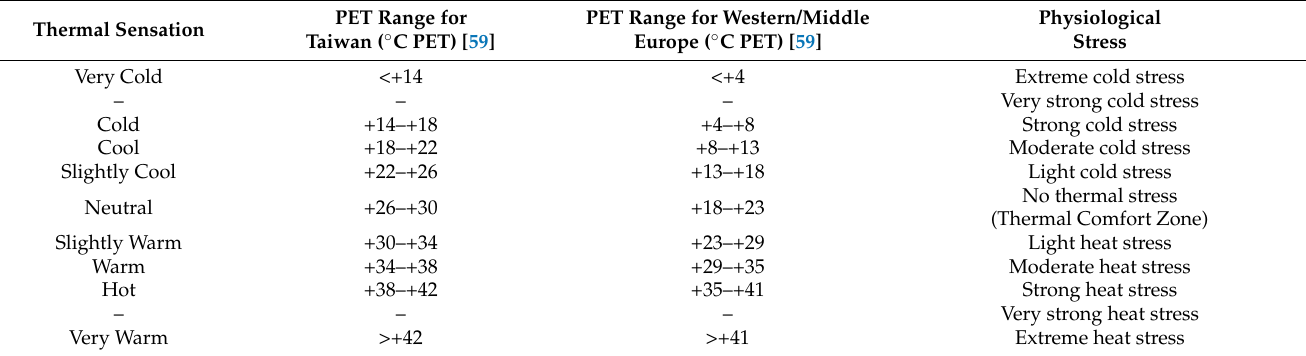
Table 5. PET Thermal Index, corresponding classes, thermal sensation, and physiological